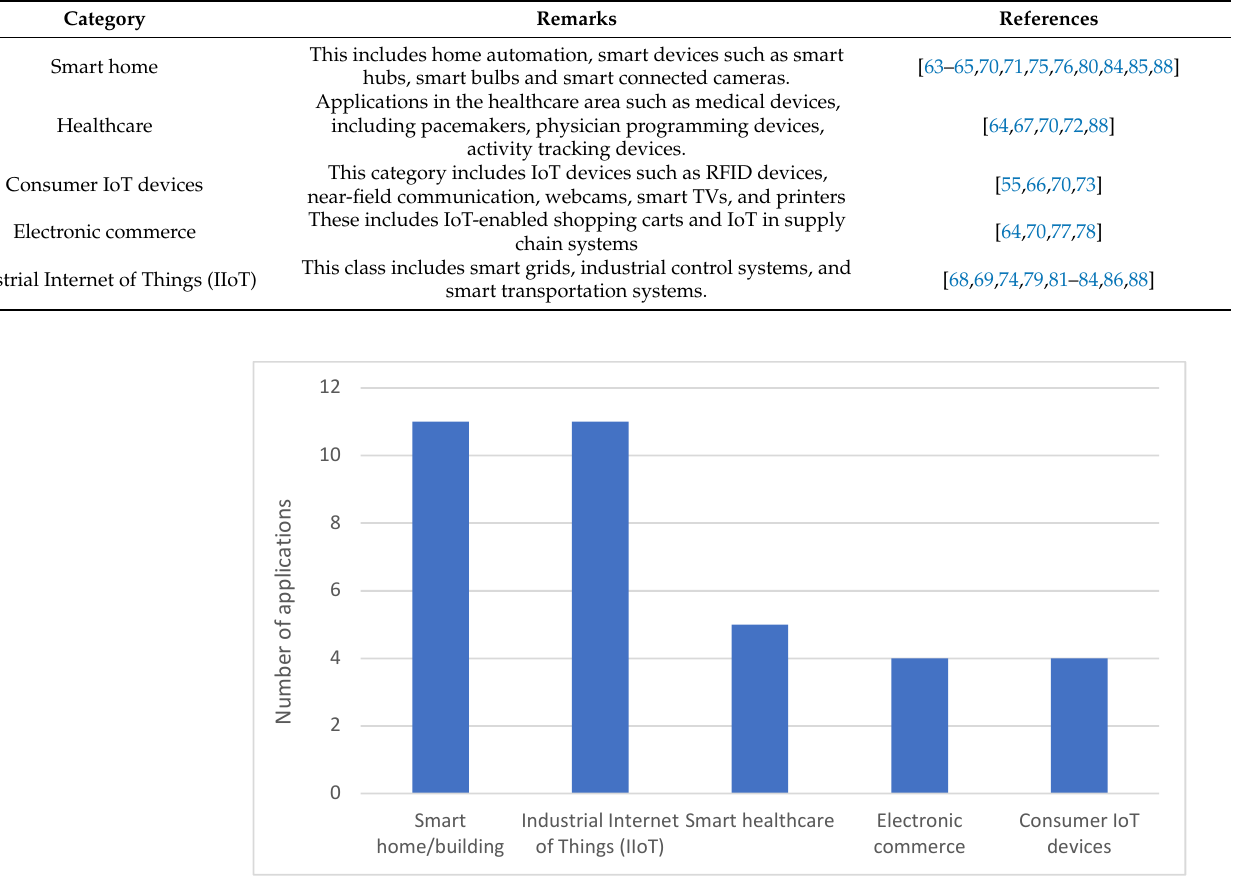
Figure 11. Distribution of IoT application domains used in the assessment frameworks.